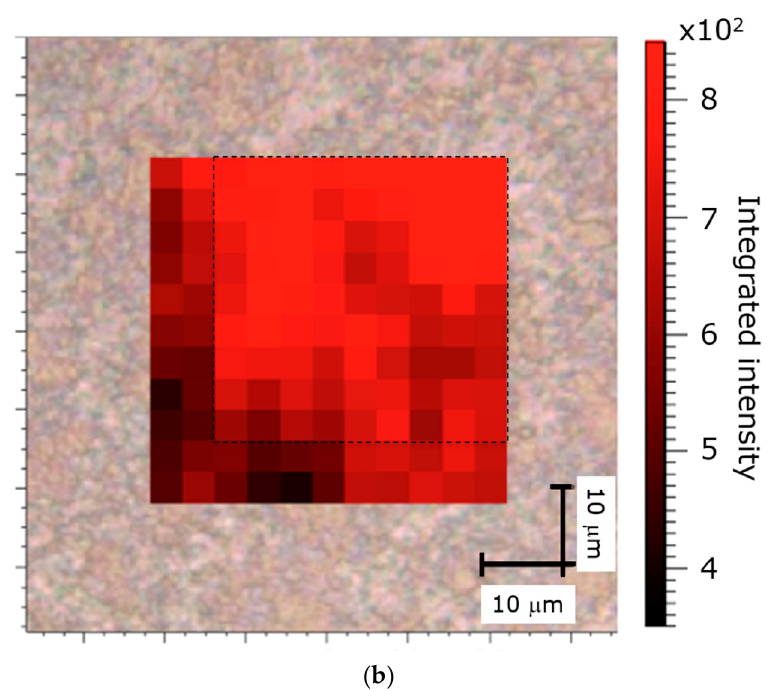
Figure 4. ( a ) Raman spectra of benzenethiol (BZT) adsorbed over nanowires (black line) and over evaporated gold surface (dark yellow) compared to the DFT calculations: generalized gradient approximations (GGA) approximation (red line) and LDA(Local Density Approximation) (blue line). The inset shows the absence of Raman signal coming from the bare device. In this case, the laser power was fixed to 10 mW and acquisition time of 1 s. In the side panels, the main vibrational modes are reported; ( b ) SERS 2D mapping of the Raman band centered around 1572 cm − 1 of BZT deposited over Au nanowires, showing the rather uniform distribution of the signal throughout the large area of the device. The laser power and integration time were fixed to 1.25 mW and 1 s. The average intensity and the standard deviation σ in the whole area is Ῑ whole = (7.0 ± 1.4) × 10 2 . In the inner dashed subarea Ῑ sub = (7.6 ± 1.0) × 10 2 .